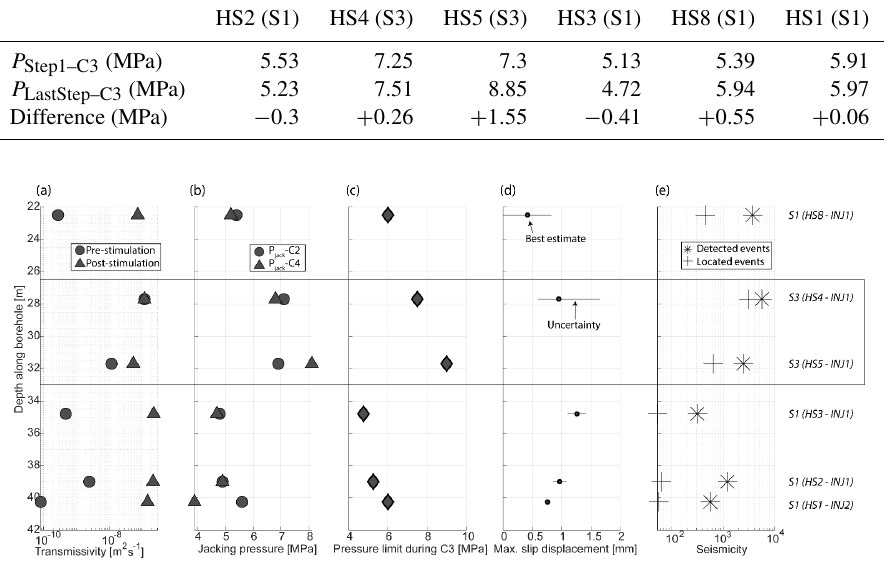
Figure 7. Hydromechanical responses of the target intervals to the stimulation experiments. Indicated are (a) pre-and post-stimulation transmissivity, (b) pre- and post-stimulation jacking pressure ( P jack –C2 & P jack –C4), (c) the injection pressure limit observed during C3, (d) estimated cumulative slip displacement, and (e) the number of detected and located seismic